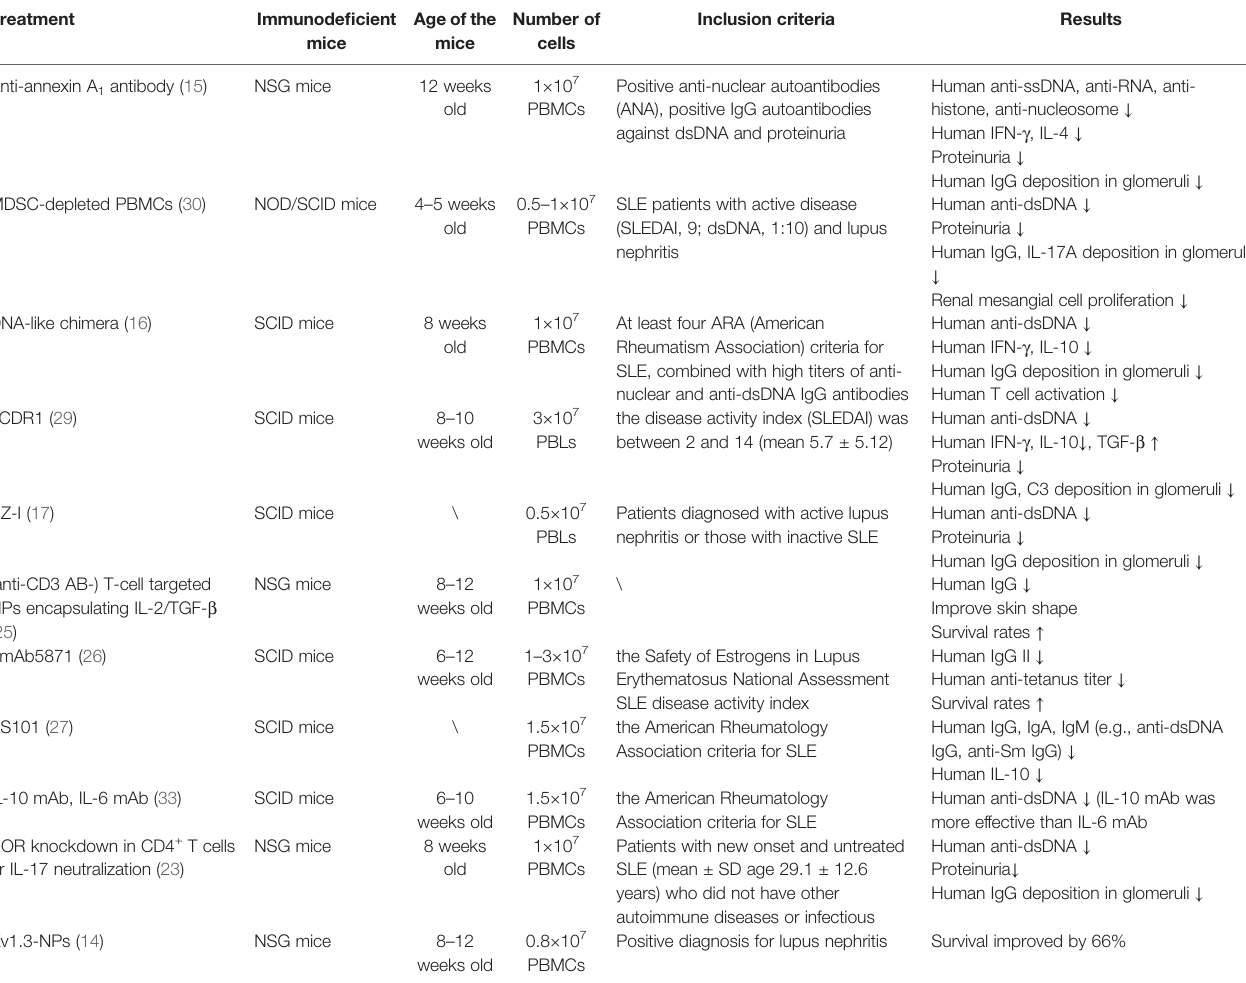
TABLE 2 | The therapeutic effect on humanized SLE